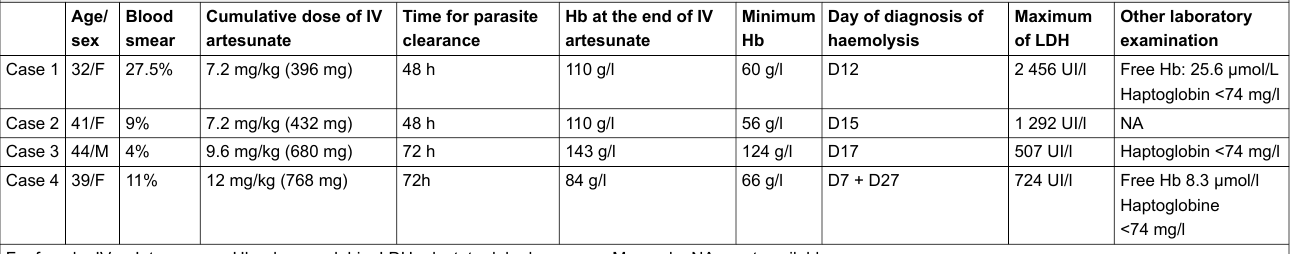
F = female; IV =: Intravenous; Hb = haemoglobin; LDH = lactate dehydrogenase; M = male; NA = not